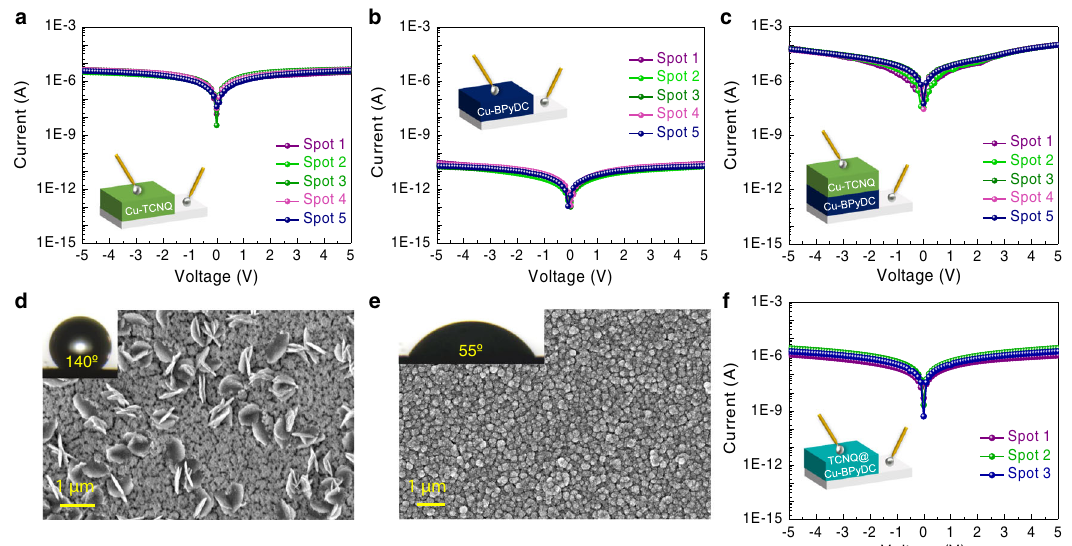
Fig. 4 | Electrical transport measurements on pristine and hetero-structured thin fi lms. a Cross-plane I – V characteristics recorded on fi ve different spots (marked as 1 to 5) in pristine Cu-TCNQ thin fi lm (inset: schematic of measurement with top and bottom eutectic GaIn contacts). b Cross-plane I – V characteristics recorded on fi ve different spots (marked as 1 to 5) in pristine Cu-BPyDC thin fi lm (inset: schematic of measurement with top and bottom eutectic GaIn contacts). c Cross-plane I – V characteristicsrecorded on fi vedifferentspots(markedas1to5) intheCu-TCNQ/Cu-BPyDCthin fi lm(inset:schematicofmeasurementwithtopand